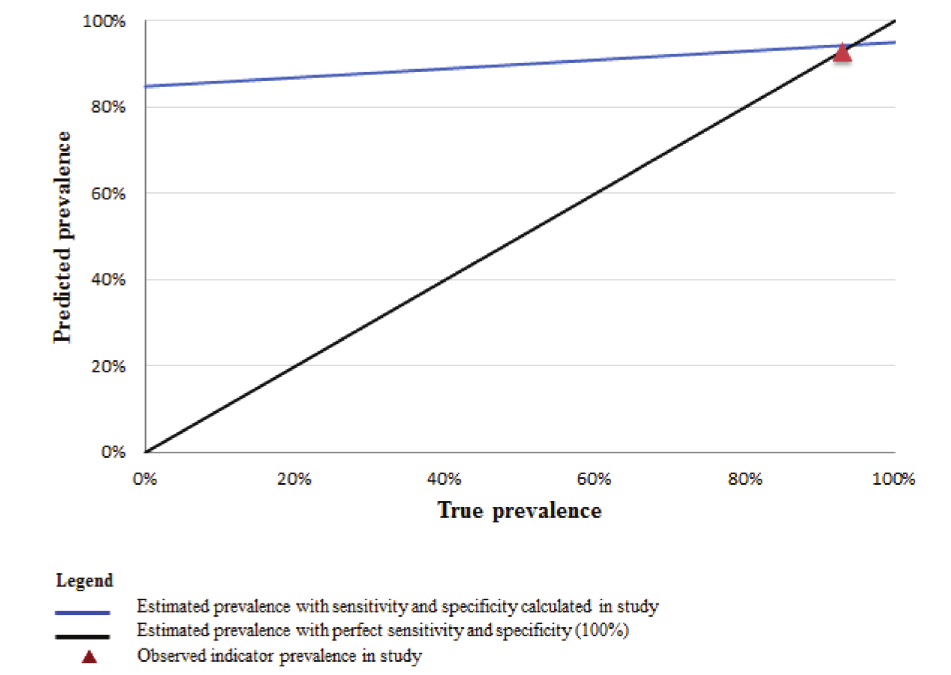
Figure 2. Predicted prevalence of skilled birth attendance based on sensitivity and specificity of women’s reports by true